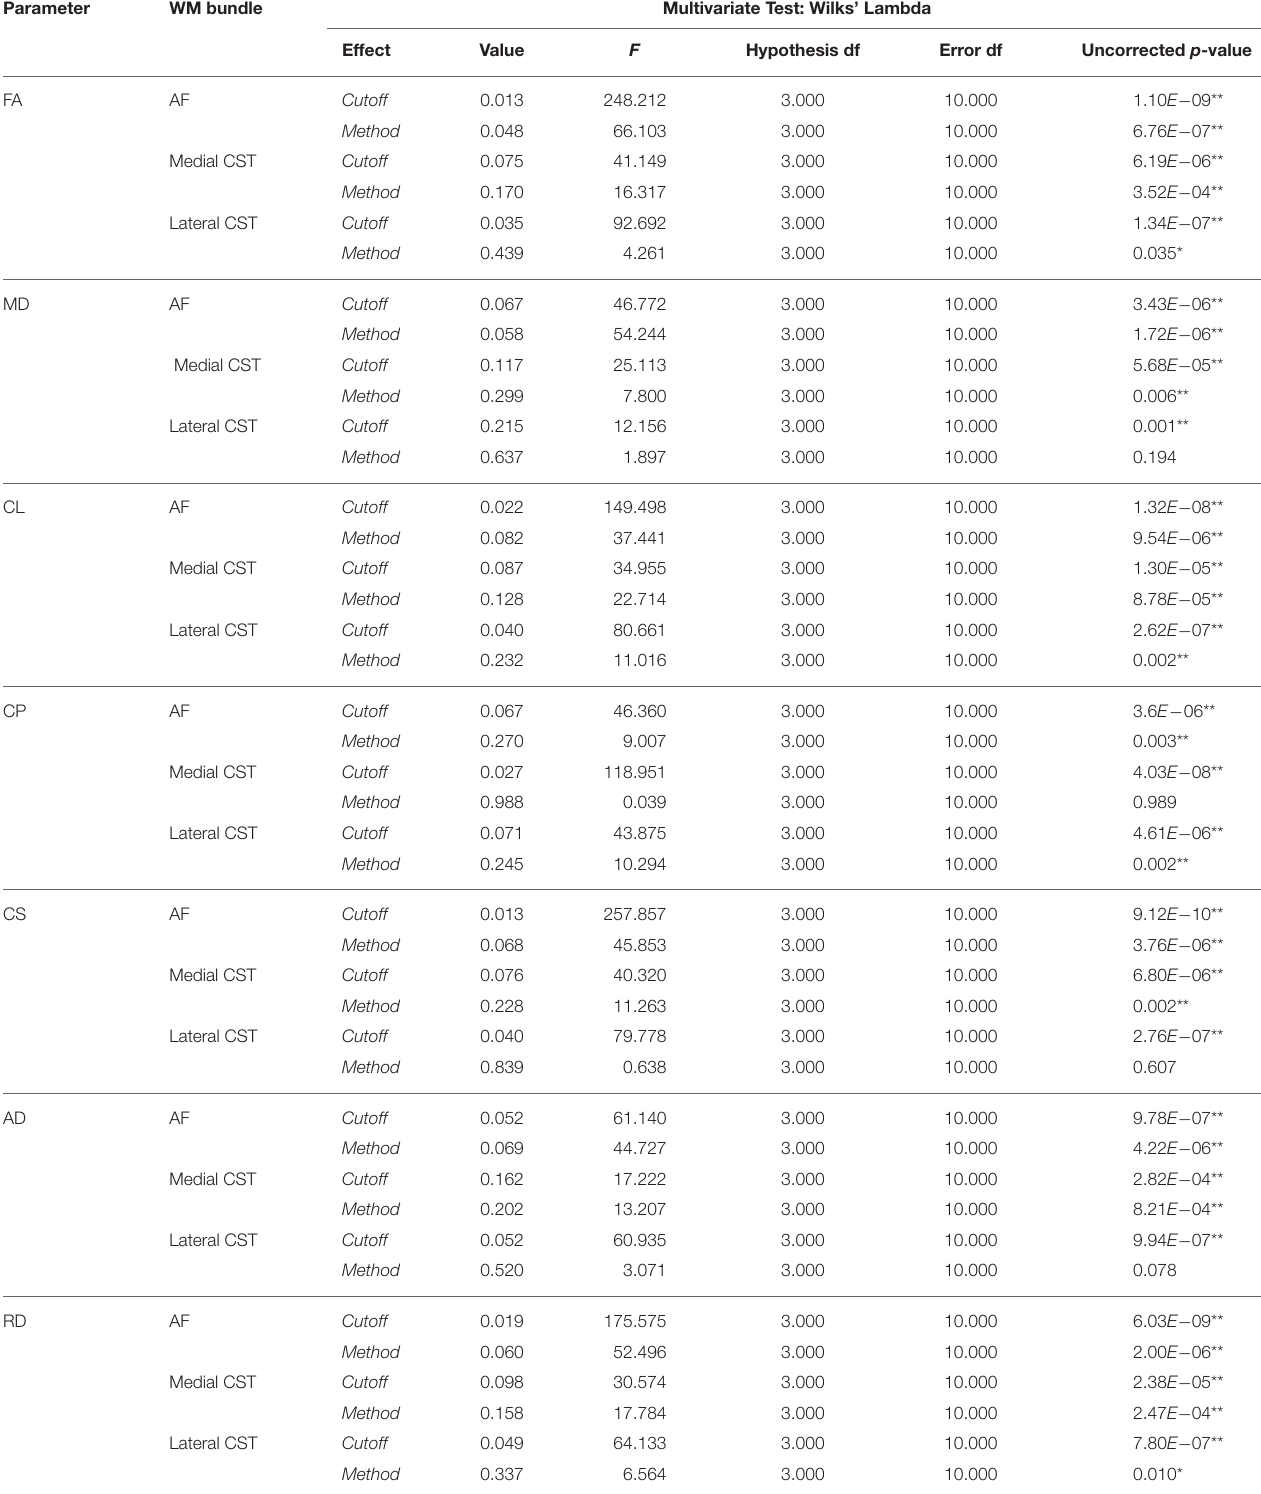
TABLE 2 | Tractograms cutoff and tractographic algorithm impact on Diffusion Tensors features.